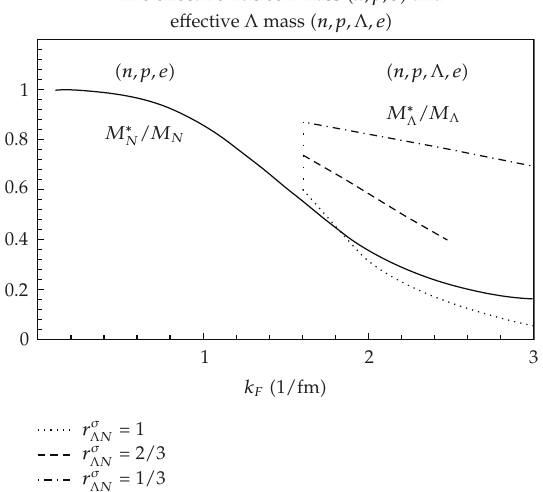
Figure 4: The e ff ective masses of N and Λ . Note that the e ff ective mass of hyperon shows M ∗ Λ / M Λ ∼ 1 as (cid:5) 1 / 3. The smaller coupling ratios indicate less density-dependent interactions for the hyperon. r σ Λ N (cid:7) 3.1 (cid:8) , and the binding energy at the onset-density, α H , should be the lowest energy level of the hyperon H (cid:7) the hyperon single particle energy at saturation (cid:8) . The Hugenholtz-Van